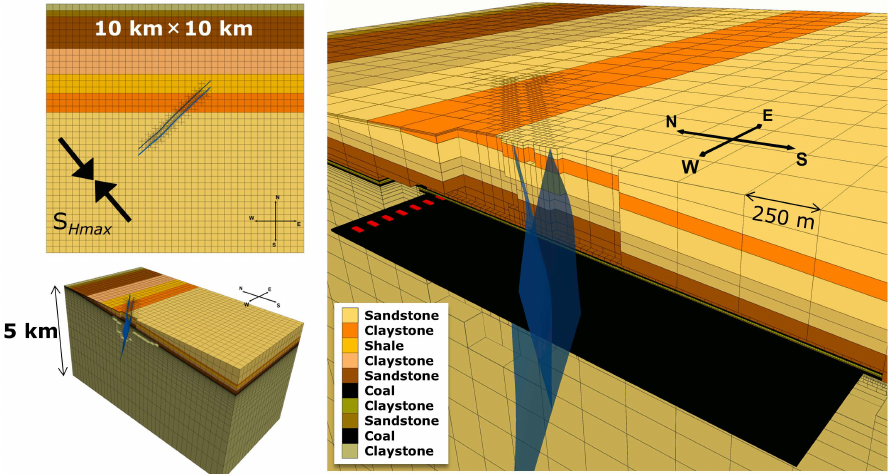
Figure 1. Geometry of the coupled thermo-mechanical 3D UCG model with the implemented double fault (blue) from three different perspectives: orientation of the maximum horizontal stress (S Hmax ) and lateral model dimensions in: plane-view ( top left ); 3D cross-section view ( bottom left ); and close-up 3D cross-section view ( right ) with the target coal seam and UCG channels considering a coal pillar width of 60 m. The model comprises ten lithological units with a target coal seam thickness of 11 m at depths from 370 to 580